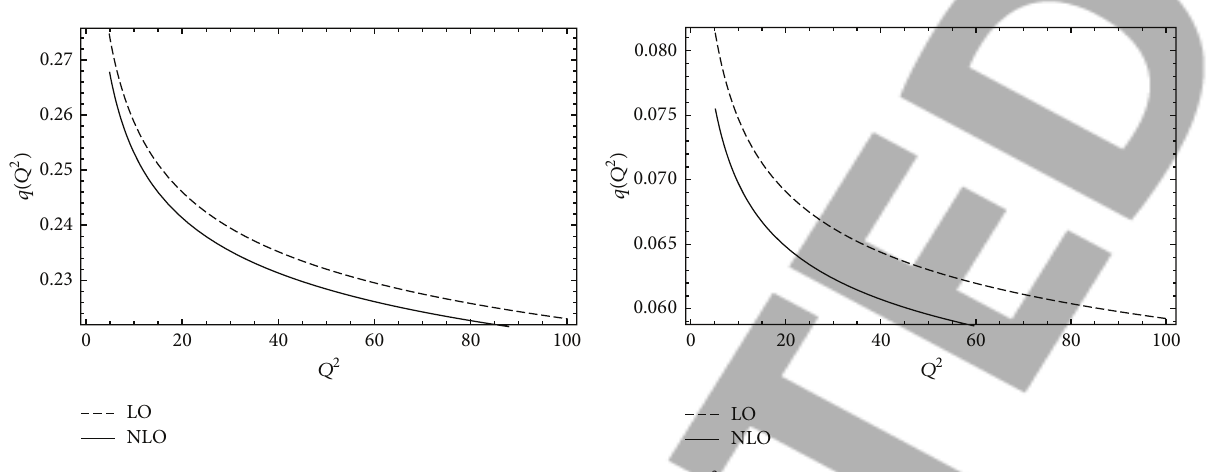
Figure 1: First and second moment of valence parton density versus 𝑄 2 values at the LO and NLO approximations.